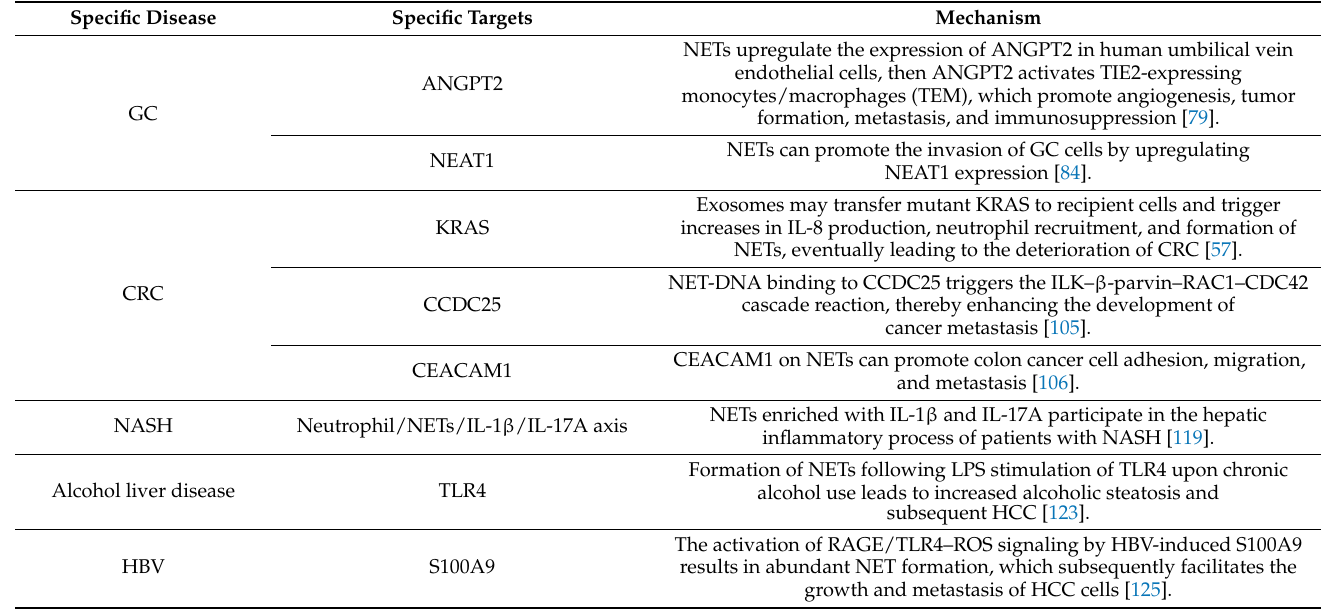
Figure 2. Specific targets of NETs in various diseases. This figure has been created with https://app.biorender.com (accessed 28 November 2022). Table 1. Specific targets of NETs in various diseases and related mechanisms.